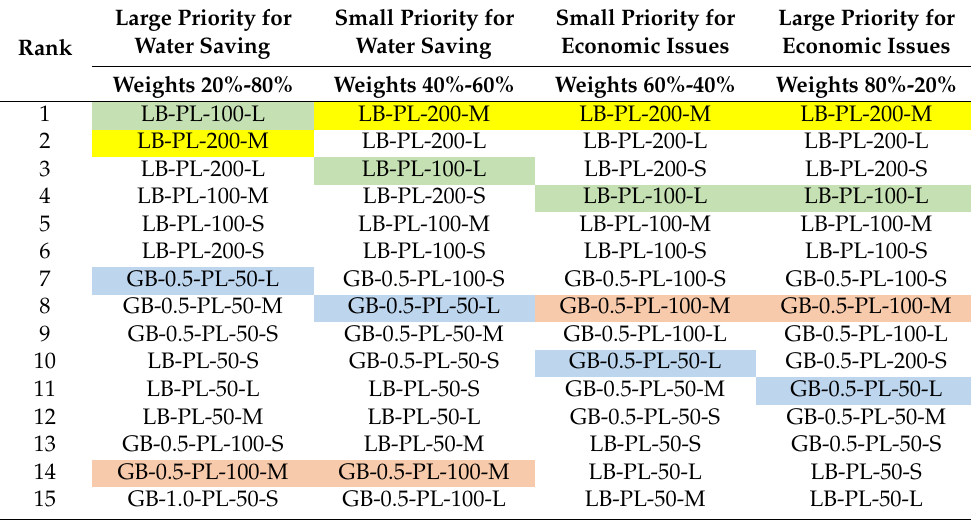
Table 13. Changes in ranking of the first 15 ranked design alternatives for a medium infiltration soil when priority scenarios relative to water saving and to farm economic results are modified. Some LB and GB alternatives are highlighted for easily observing changes in ranking when priorities are